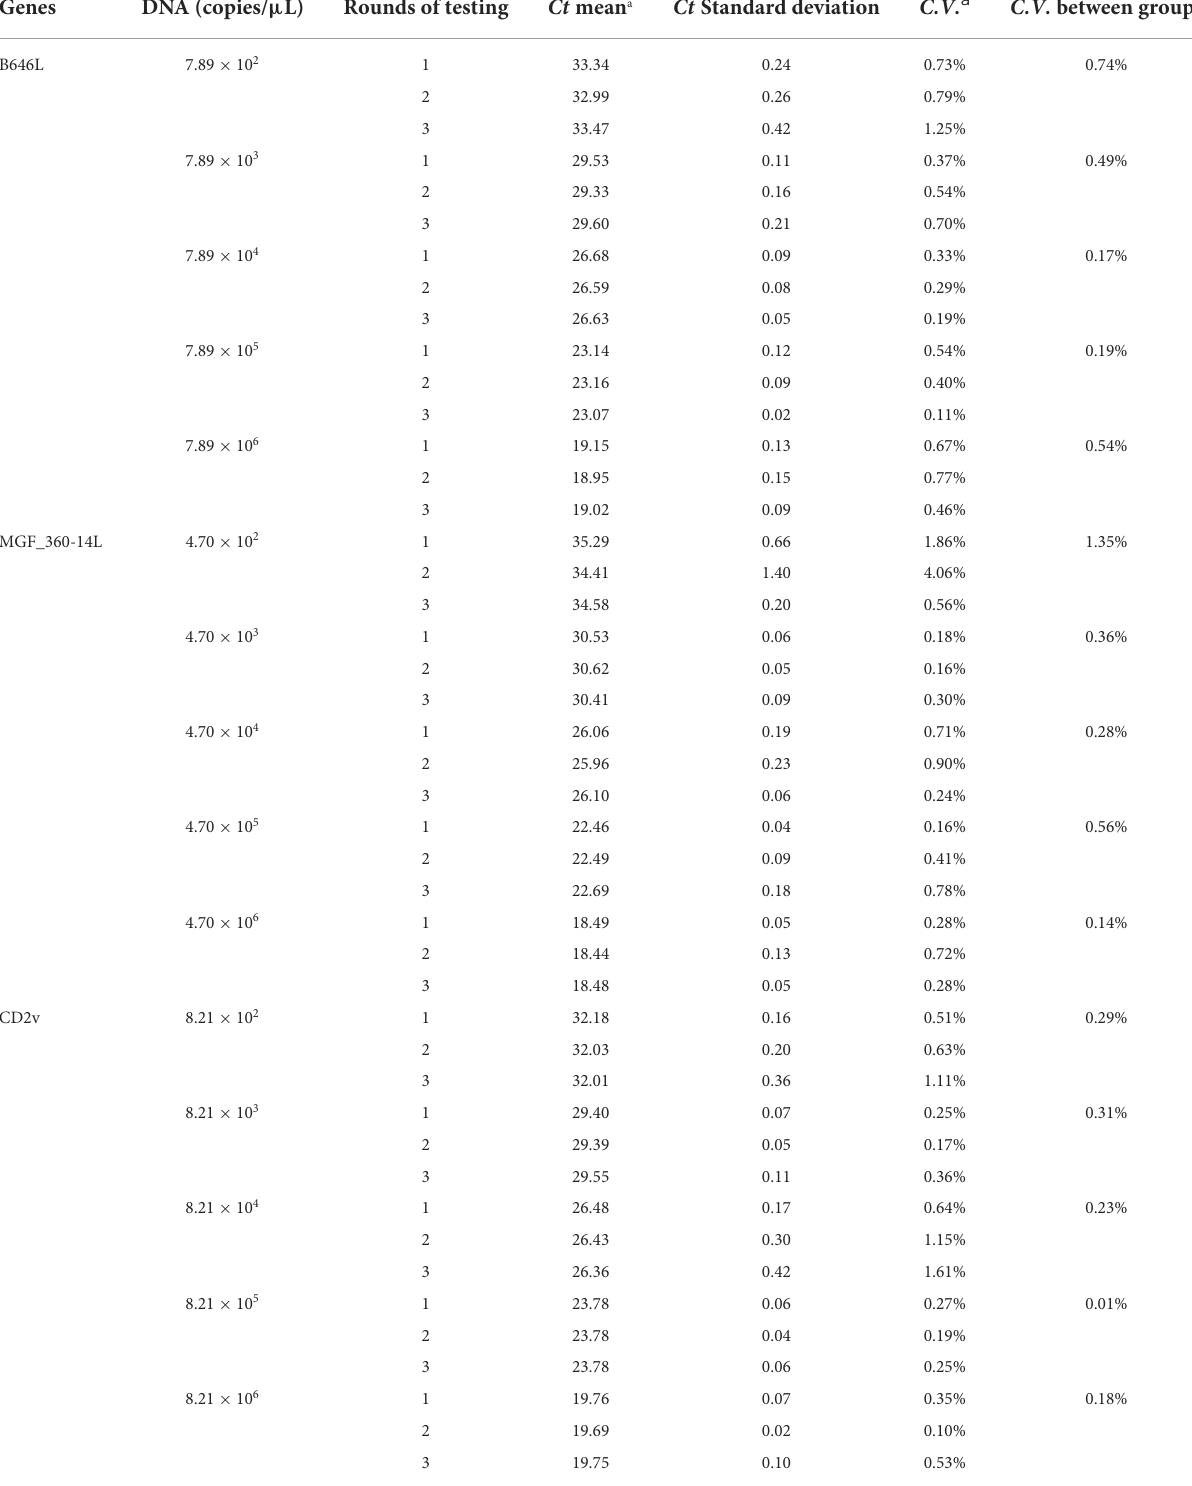
TABLE 2 Validation of the Detection repeatability of the developed triplex real-time PCR method. Genes DNA (copies/ µ L) Rounds of testing Ct mean